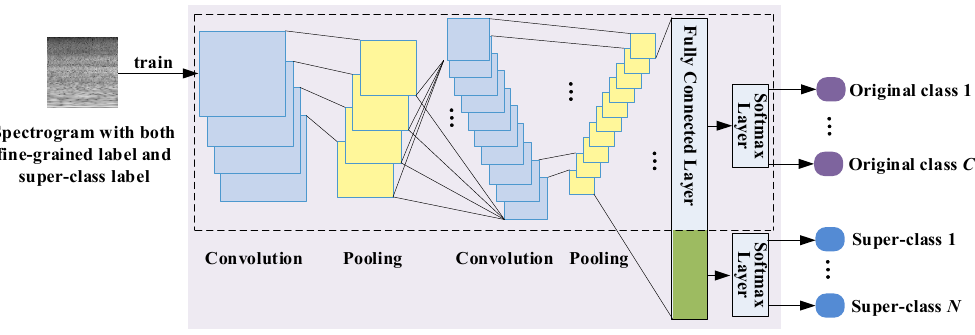
Figure 4. Structure of the multitask learning model. The structure within the dashed box is identical to the basic CNN model. An additional softmax layer has been added and fully connected to the next-to-last layer. The green area above represents the newly added connections in the fully connected layer. Both original acoustic scene labels and super-class labels are simultaneously predicted here.